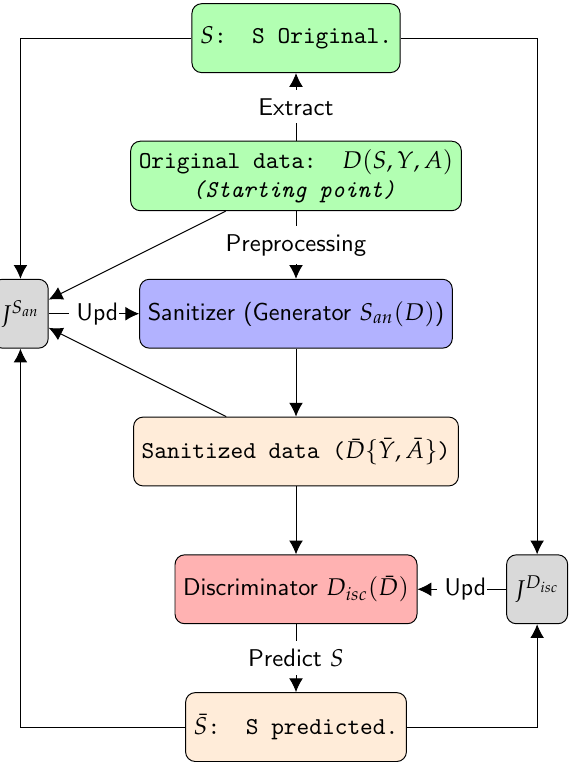
Figure 1. Overview of the framework of GANSan . The objective of the discriminator is to predict S from the output of the sanitizer ¯ D . The two objective functions that the framework aims at minimizing are, respectively, the discriminator and sanitizer losses, namely J D isc and J S an